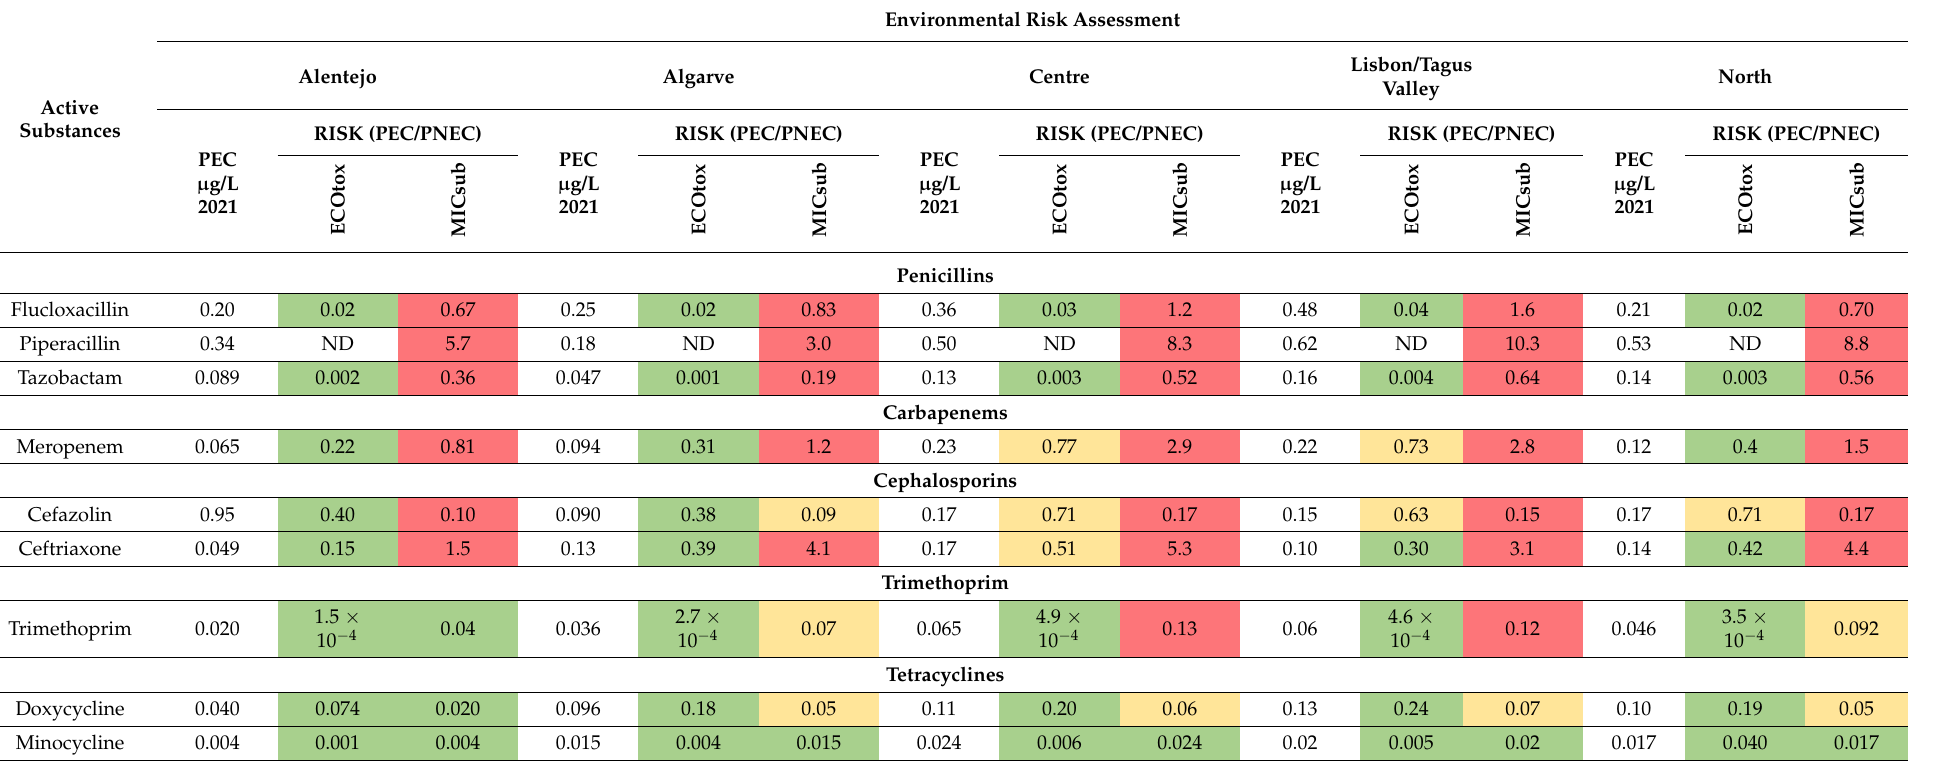
Table 2. PEC and ecotoxicological/microbiological risk quotients (RQs) for the selected substances in surface